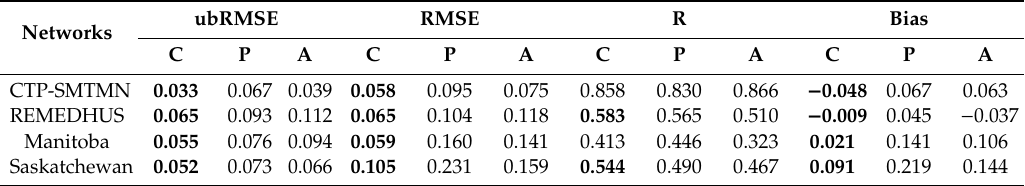
Table 2. The ubRMSE, RMSE, R and bias of the comparison between the in-situ SM (IDW) with the active (A), passive (P) and combined (C) CCI SM product for CTP-SMTMN, REMEDHUS and RISMA (Manitoba, Saskatchewan). Bold numbers indicate that the combined products perform